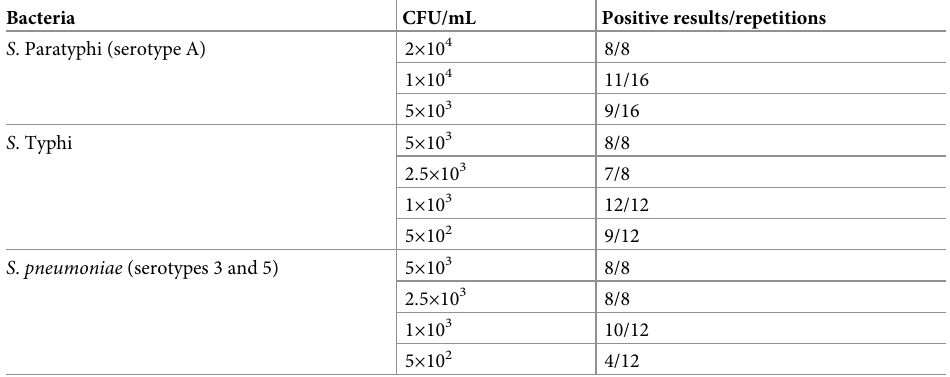
Table 3. Bacterial concentrations tested in the FeverDisk to calculate the limit of detection and the ratio of posi- tive results within the total repetitions assayed.